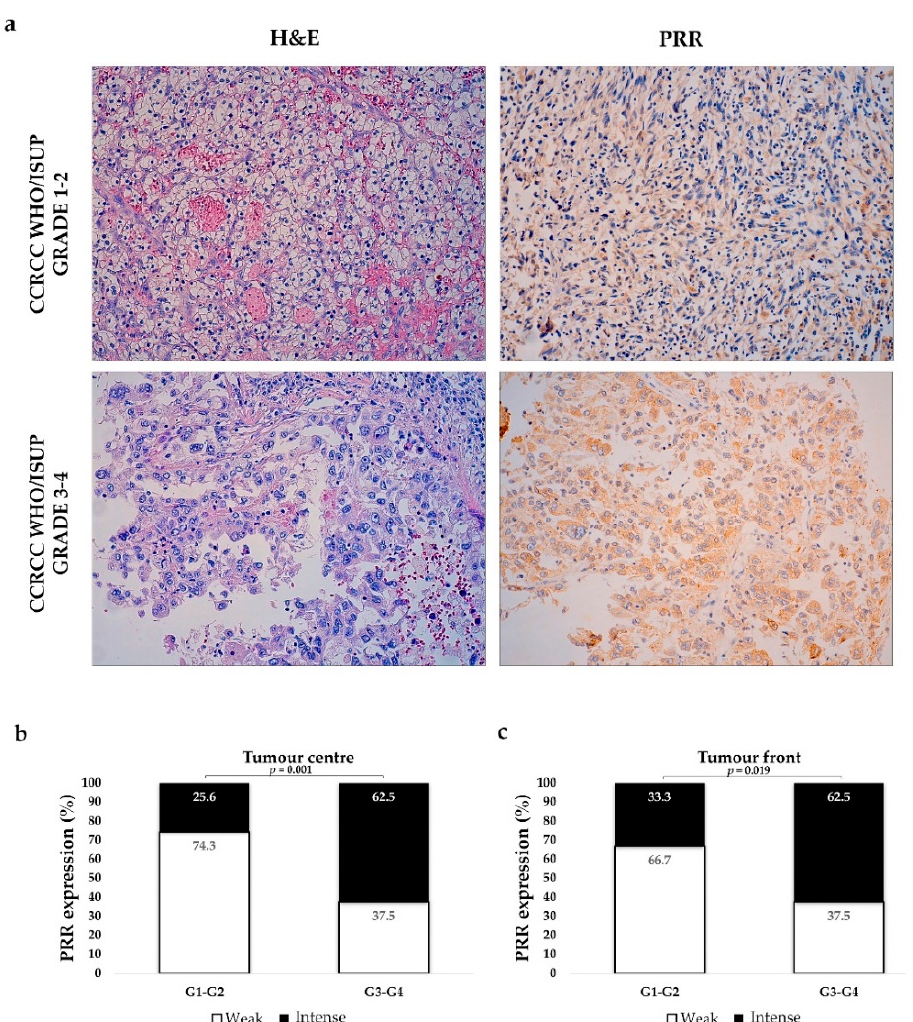
Figure 3. PRR expression according to tumour grade. Immunostaining at the tumour centre of low- and high-grade CCRCCs ( a ). Original magnification, × 250. H&E: Hematoxilin–Eosin. PRR staining intensity both at centre ( b ) and front ( c ) of tumours was grouped as weak and intense. Staining was more intense in high-grade CCRCCs. Chi-square test was used for data analysis.